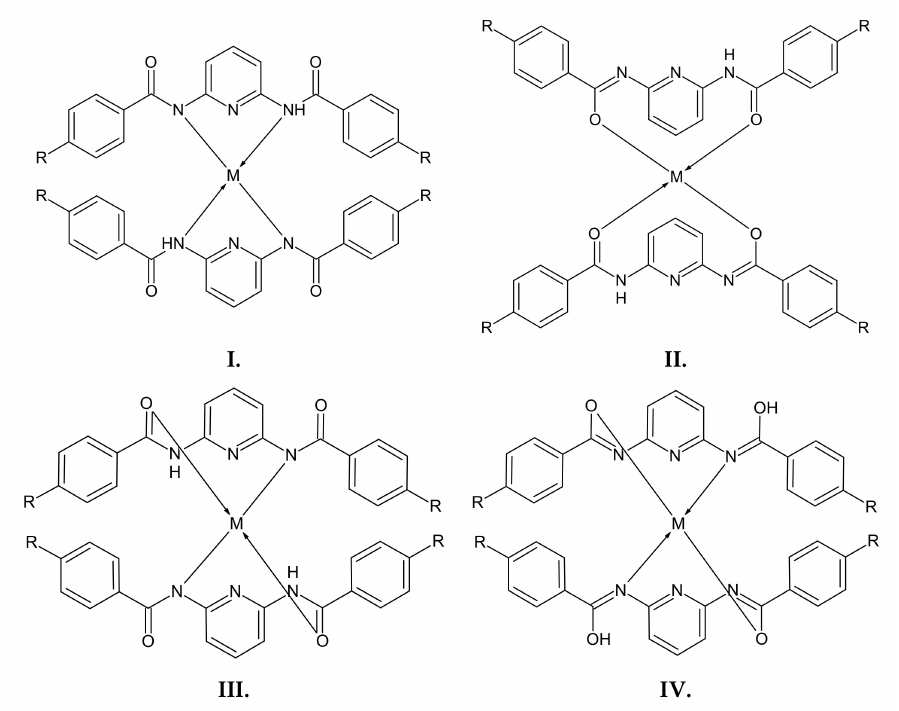
Figure 1. The proposed structures (I, II, III, and IV) of the complexes of compounds A1–A3 and metal ions